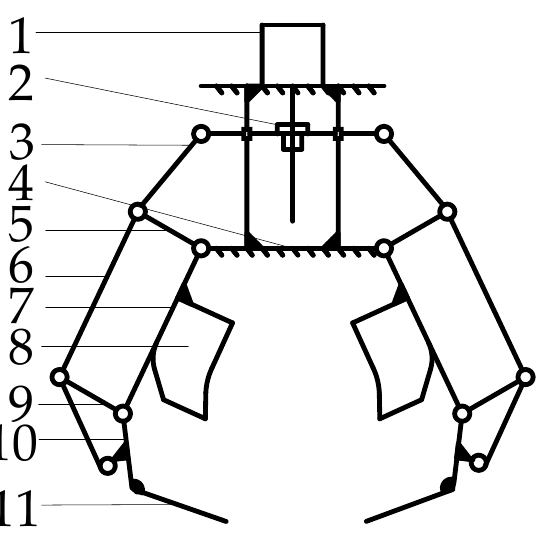
Figure 2. Schematic diagram of manipulator structure: 1 stepper motor; 2 lift platforms composed of worm-and-nut; 3 drive-rod; 4 frame bottom plates; 5,6 linkage; 7,9 rockers; 8 clamp guard plates; 10 swing-rod; 11 cutting-blade.